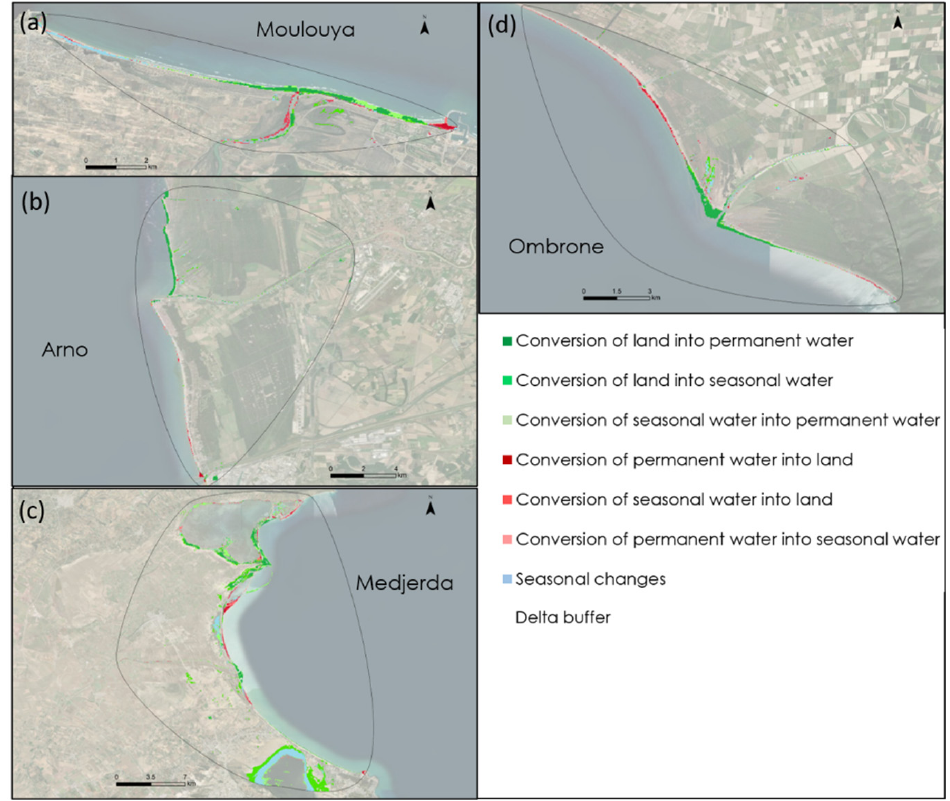
Figure 5. Maps of categories of land → water and water → land conversions for the Moulouya ( a ), Arno ( b ), Medjerdja ( c ), and Ombrone deltas ( d ), culled from the Global Surface Water (GSW) database [7]. The spatial pattern shows a strong coastal zone component (40%–80%), relative to the entire delta